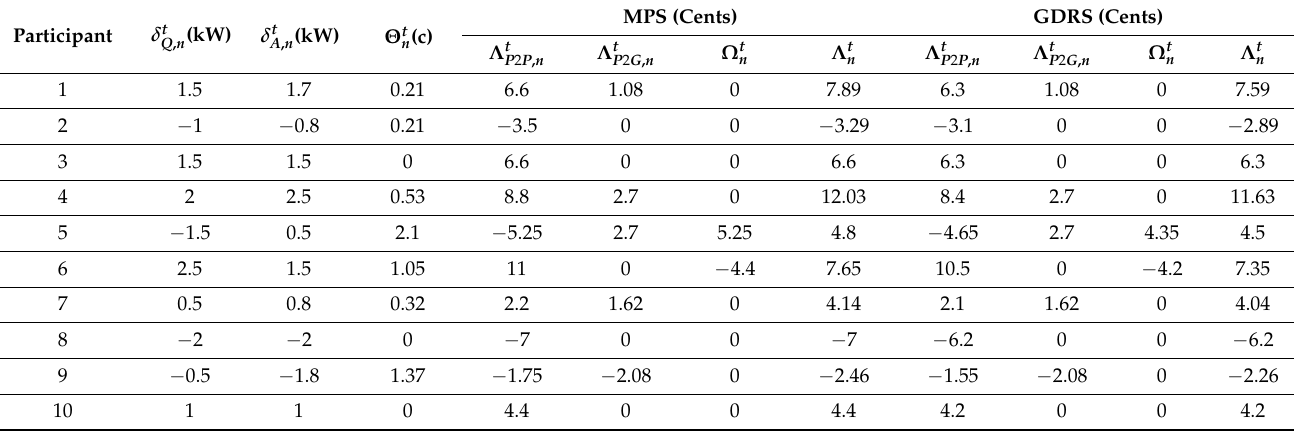
Table 3. MPS and GDRS-based penalty analysis for participants’